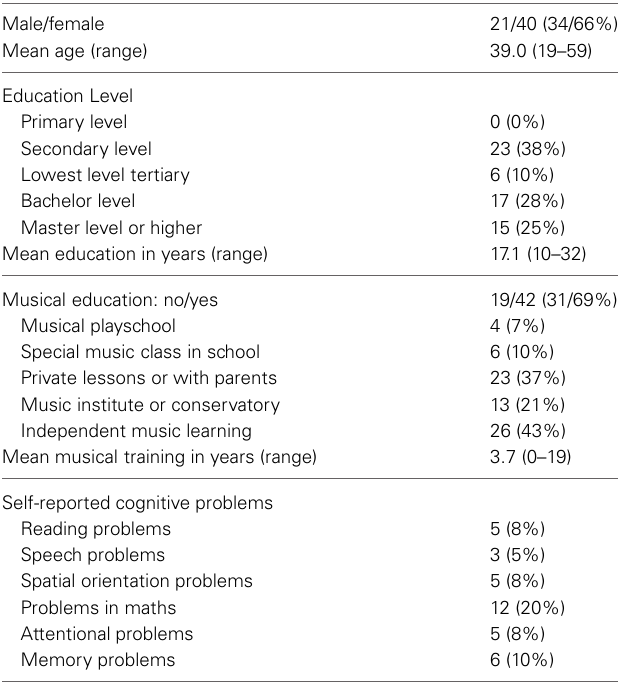
Table 1 | Characteristics of the